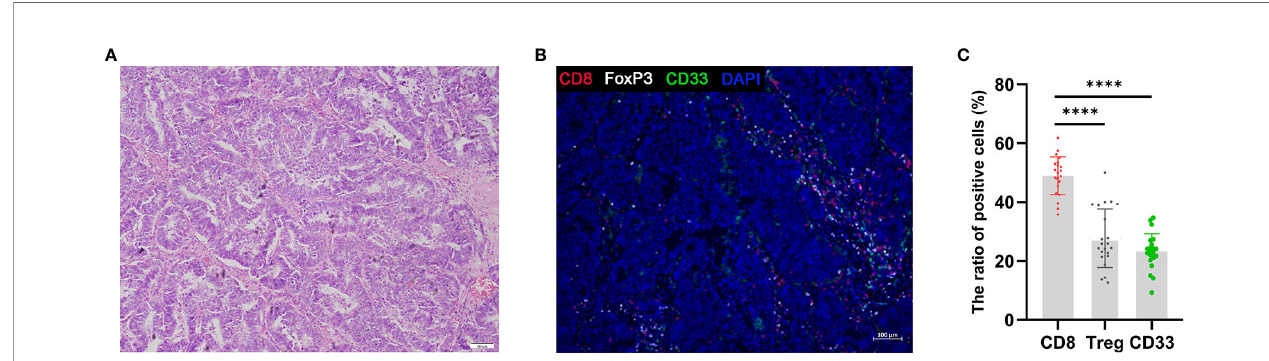
FIGURE 6 | Triple fl uorescent immunohistochemistry of AEG tumors shows T-cell in fi ltration. H&E staining of AEG tumor tissue (A) . Representative image after multispectral imaging for CD8, FoxP3, CD33 together with a nuclear marker, DAPI (B) . Tumor sections were sequentially stained using Opal fl uorophores for CD8 (red), FoxP3 (white), CD33 (green), and DAPI (blue). The ratio of positive cells in immune cells was de fi ned as the ratio of the number of each positive immune cells to the whole number of each immune cells (red, white, and green) in a 4-mm 2 fi eld of view (C) . Data depict the mean ± SEM. The p values are represented as follows: (****p < 0.0001) (C) . 10× magni fi cation, scale bar = 100 um, applicable to